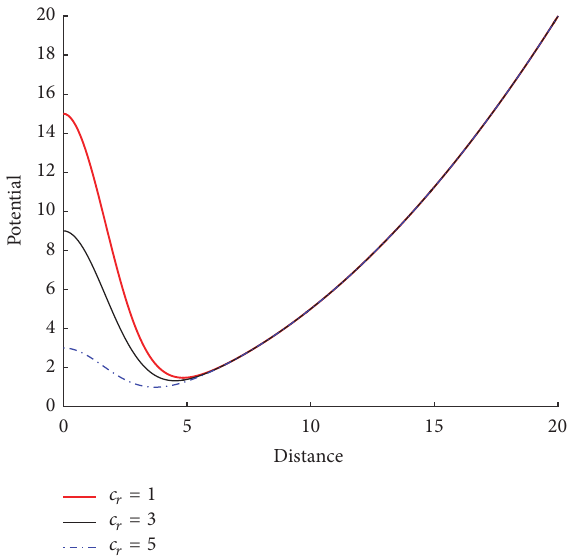
Figure 3: Interagent attract-repel potential function with various repulsive constant 𝑐 𝑟 , where 𝑐 𝑎 = 1 and 𝑅 = 3